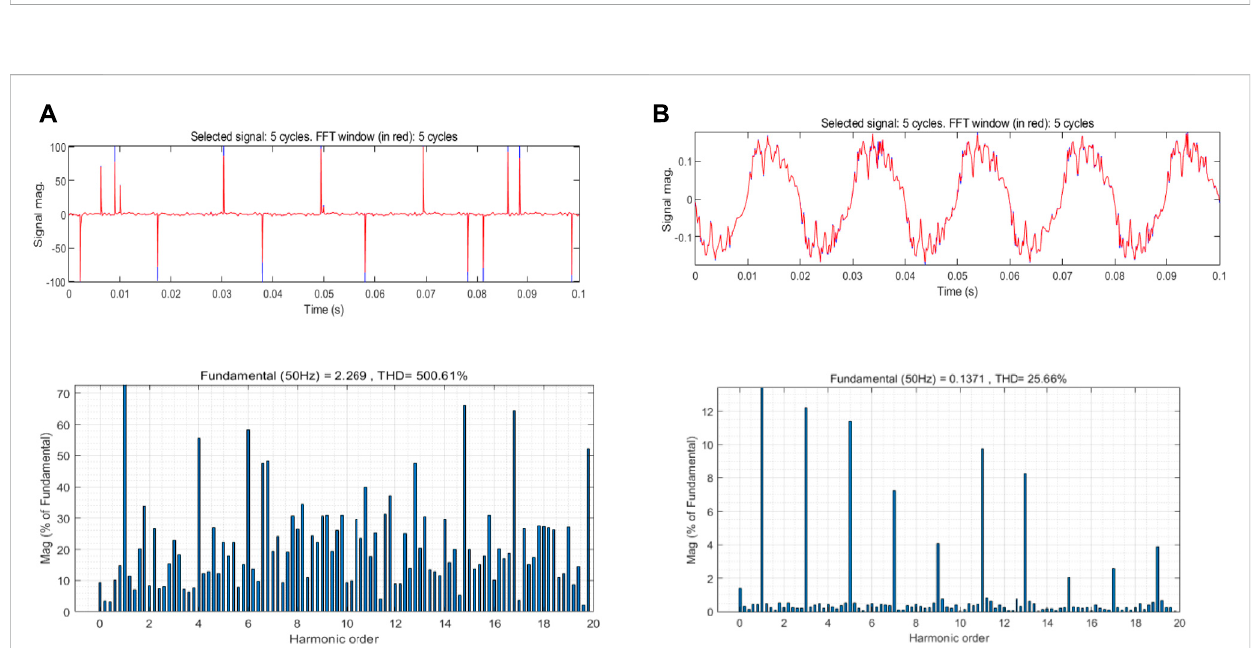
FIGURE 3 Experimental results, (A) is the time-frequency information under the failure of the computer, (B) is the time-frequency information under the normal operation of the